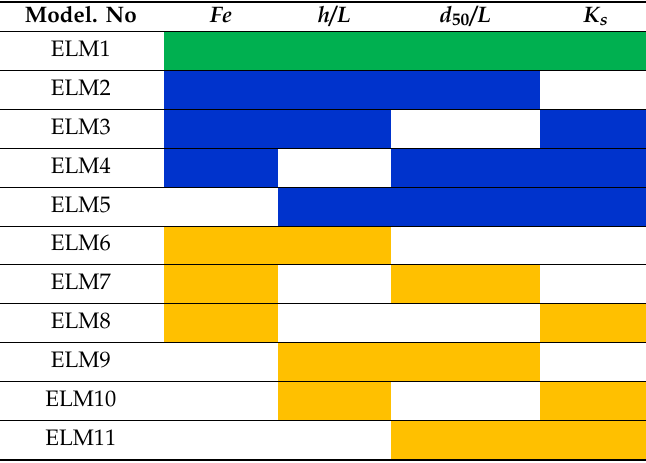
Table 2. Di ff erent input combinations, containing the e ff ective variables on abutment scour depth. Model.